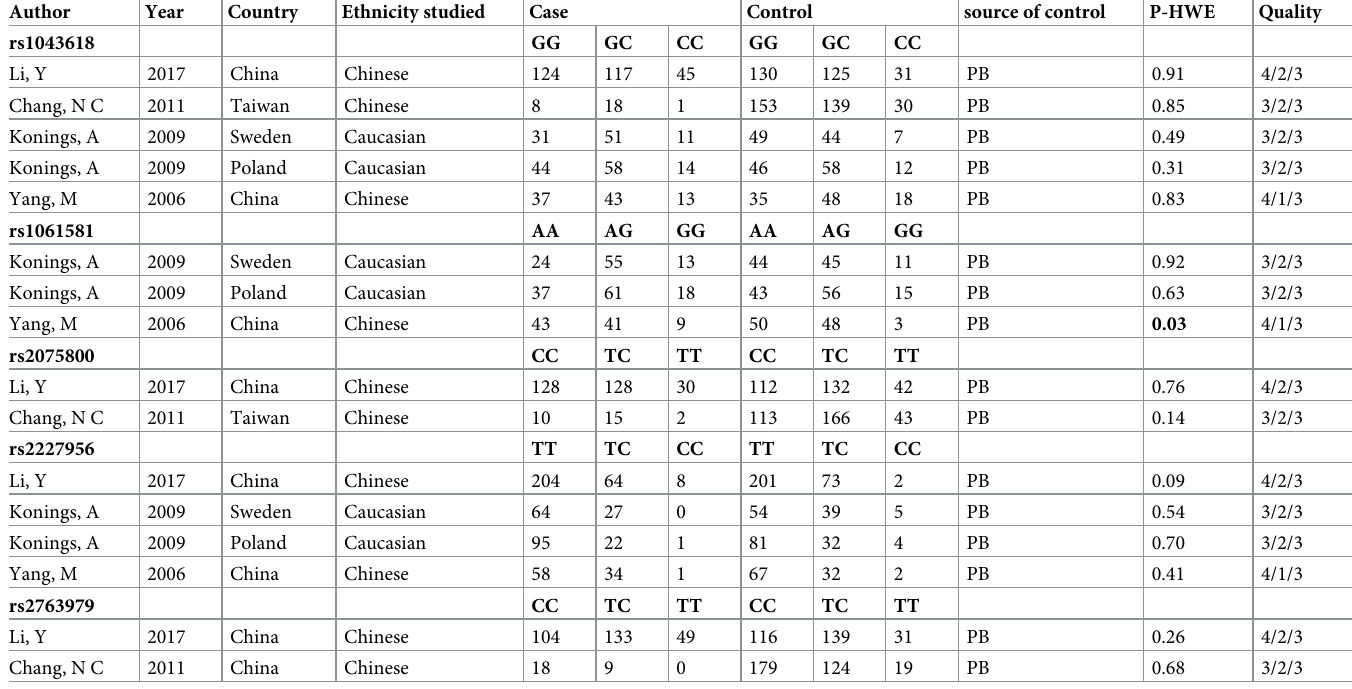
Table 1. Characteristics of studies included in the